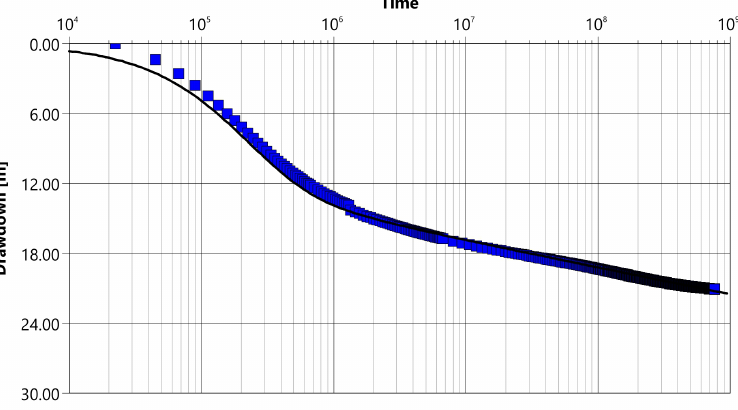
Figure 11. Analytical diagram for measurements during recovery in the W-1 well (Agarwal’s method considering well effects + Agarwal’s solution).